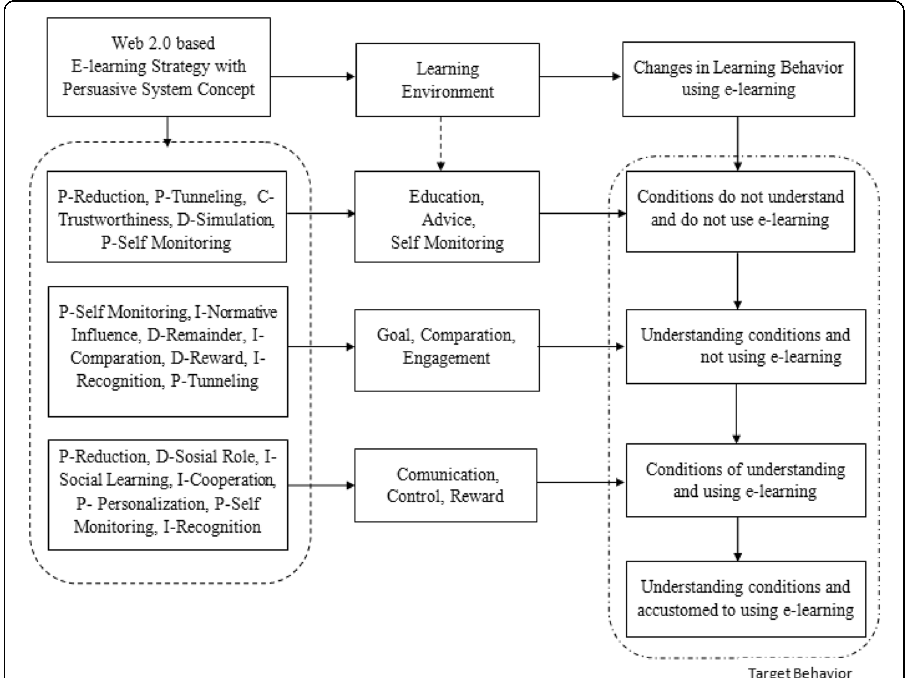
Fig. 7 The required persuasive features